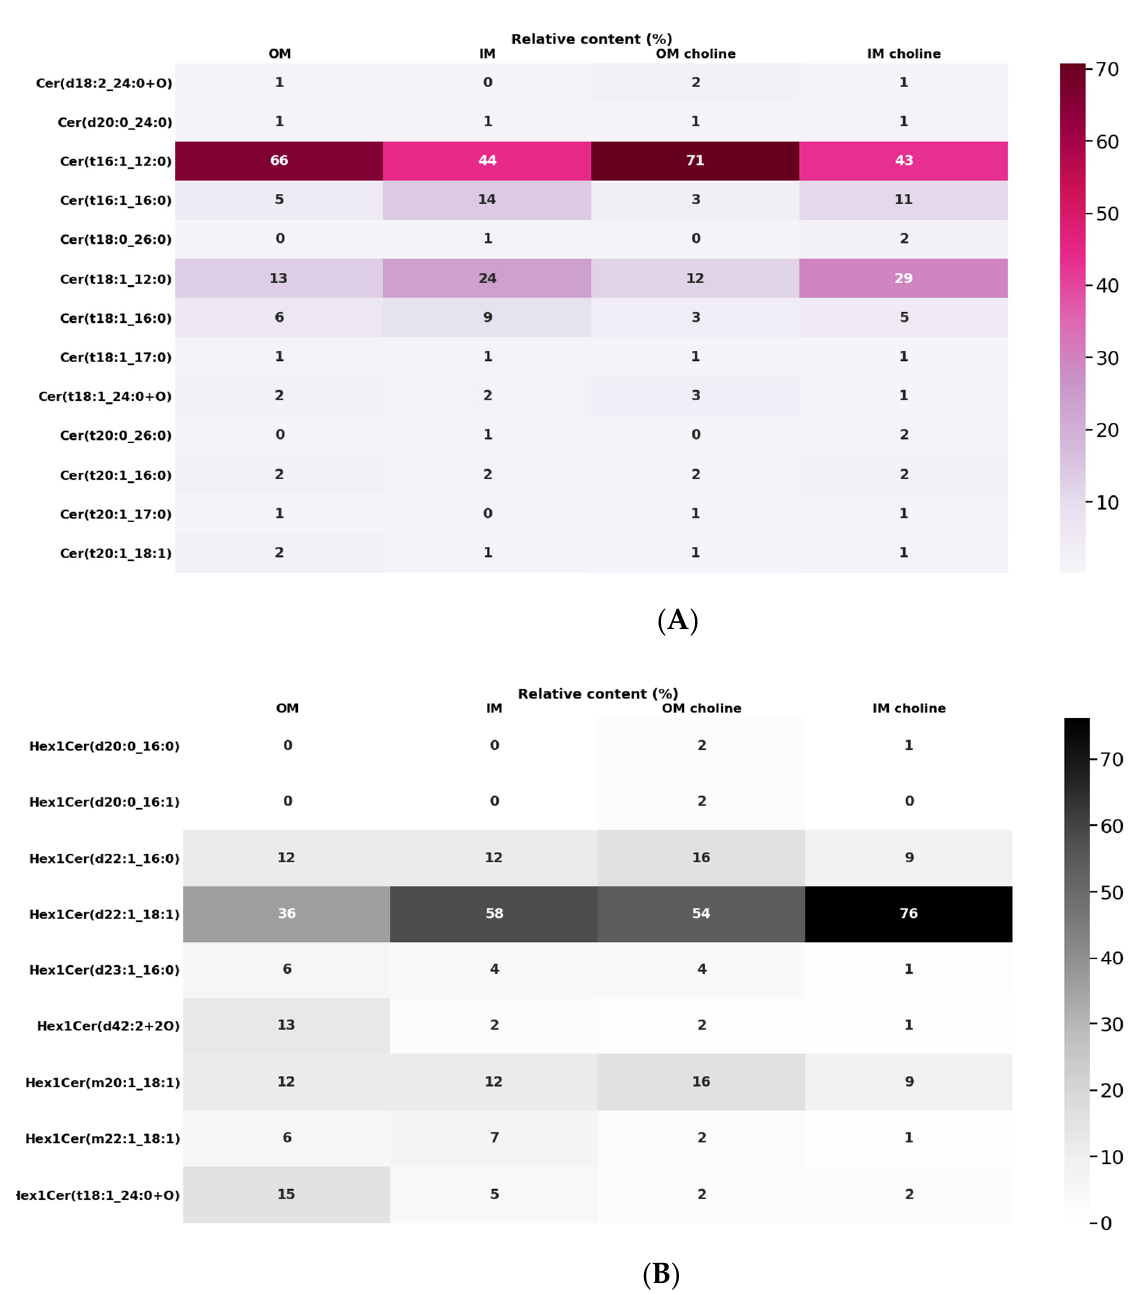
Figure 5. Ceramides ( A ) and hexosylceramides ( B ) in total lipid extracts of the OM and IM of L. gormanii cultured on the choline-supplemented and non-supplemented medium. Ceramides were analyzed by LC-MS(/MS) in the positive ionization